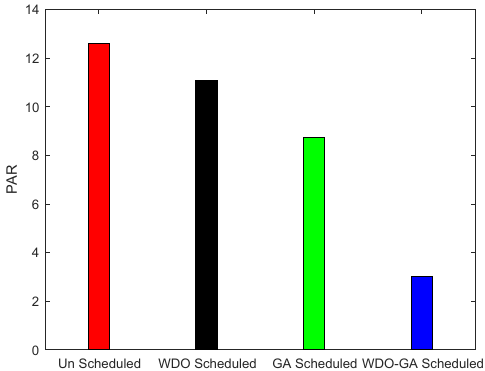
Figure 7. Scheduled and unscheduled